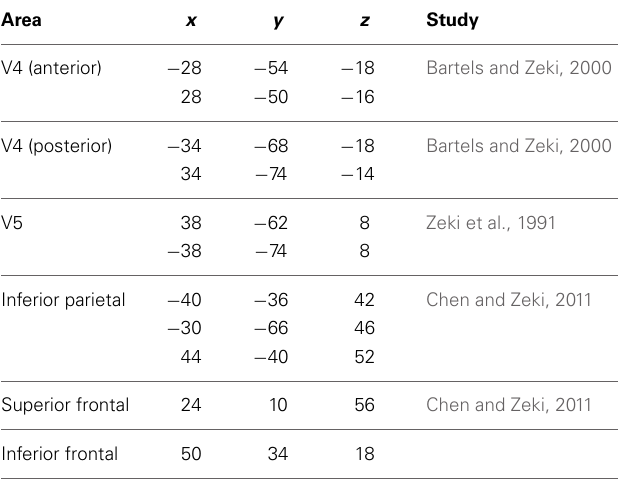
retinotopically defined V5 for motion stimuli [ t (12) = − 0 . 12, p